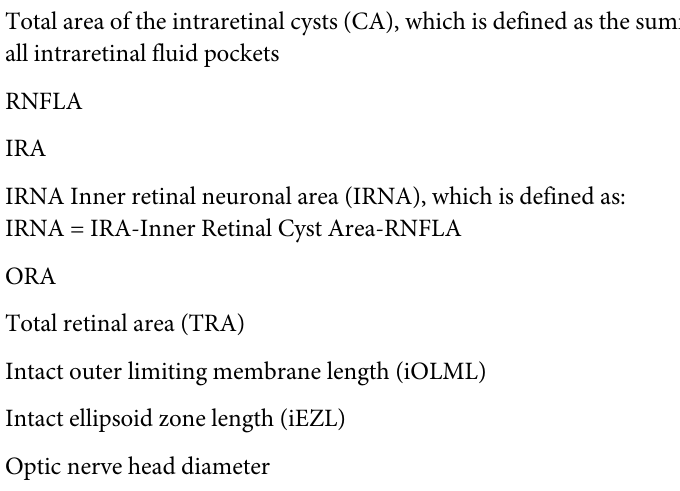
plexiform layer was defined as the “ Inner Retinal Area” (IRA). The outer plexiform layer and